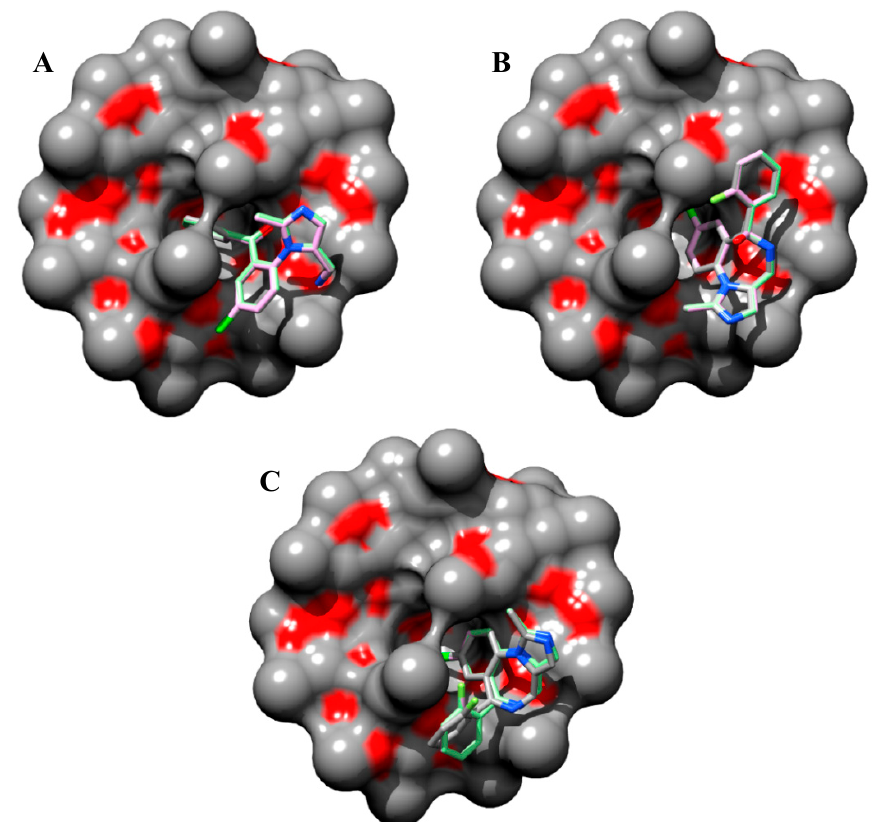
Figure 3. Predicted molecular docking modes with minimal Gibbs free energy of binding ( (cid:1986)(cid:1833) ) for open-ring ( A ), transition state intermediate ( B ) and closed-ring ( C ) form of (cid:3029)(cid:3036)(cid:3041)(cid:3031) midazolam complexed with TRIMEB. The molecular surface was reconstructed to visualize the binding cavity of uncharged trimethyl- β -cyclodextrin. The best binding poses values from three different molecular docking experiments are shown with minimal (cid:1986)(cid:1833) (cid:3029)(cid:3036)(cid:3041)(cid:3031) to reveal their conformational resemblances. Molecules are coloured according to their atom types. Hydrogen atoms are omitted for